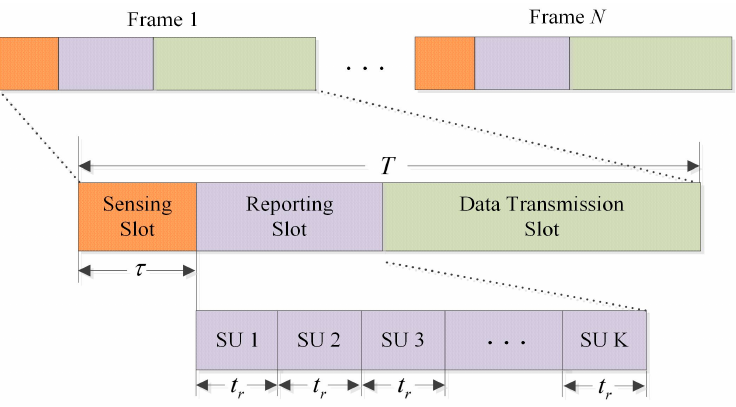
Figure 4. General TDMA-based cooperative spectrum sensing framework.